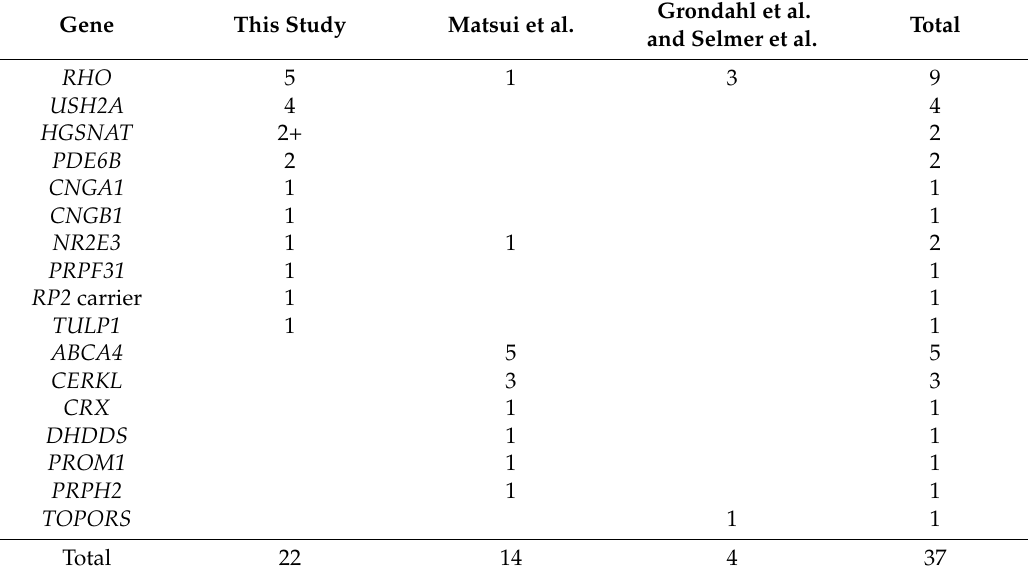
Table 3. Genes identified in patients with pericentral RP (this study), pericentral retinal degeneration [19], or pericentral retinal dystrophy [23,25], with numbers of probands solved by each gene. Grondahl et This Study Matsui et al.